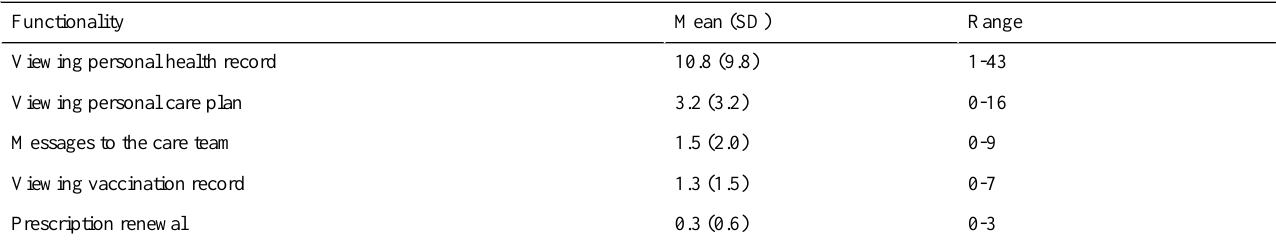
Table 2. Mean use of patient portal functionalities per patient in the intervention group (n=80) during the 6-month study period.